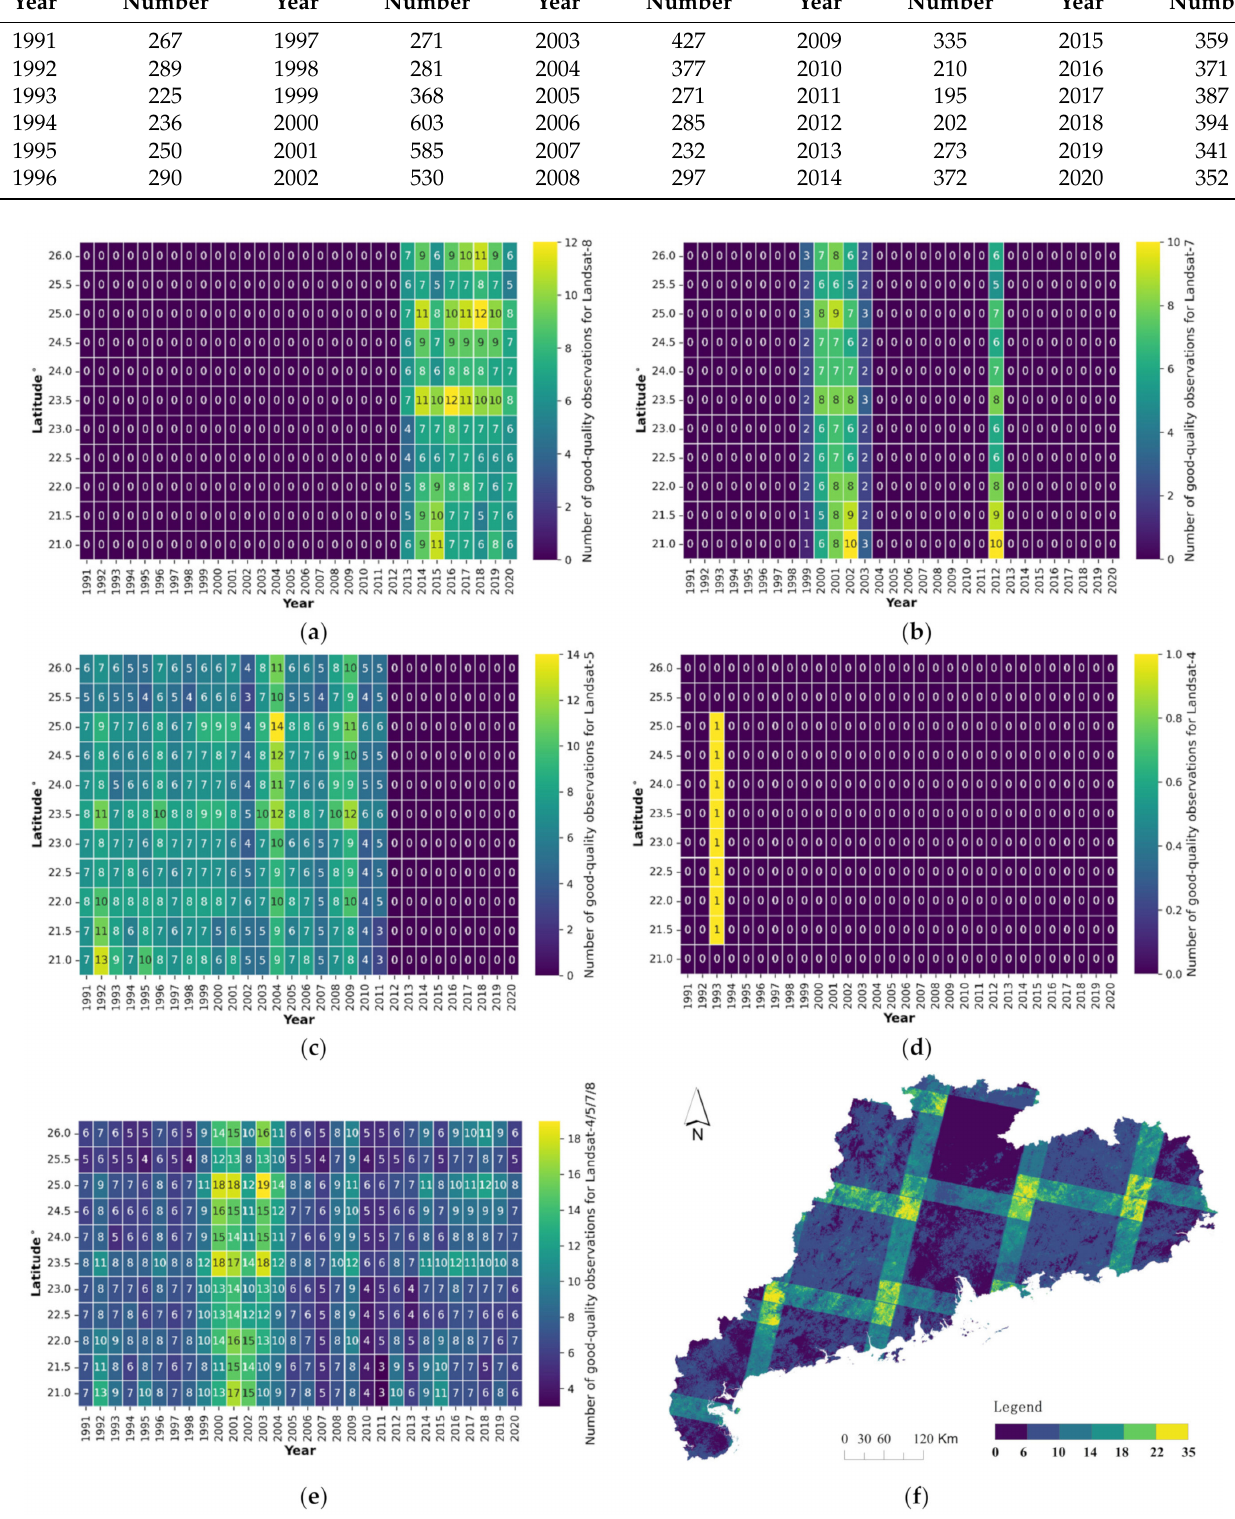
Figure 2. Good-quality observation of time-series remote sensing image from 1991 to 2020 according to the latitude. ( a – d ) show the number of Landsat 4, 5, 7 and 8 each year for 30 years. ( e ) shows total numbers in all study areas. ( f ) shows the number of Guangdong in 2019 in the form of a